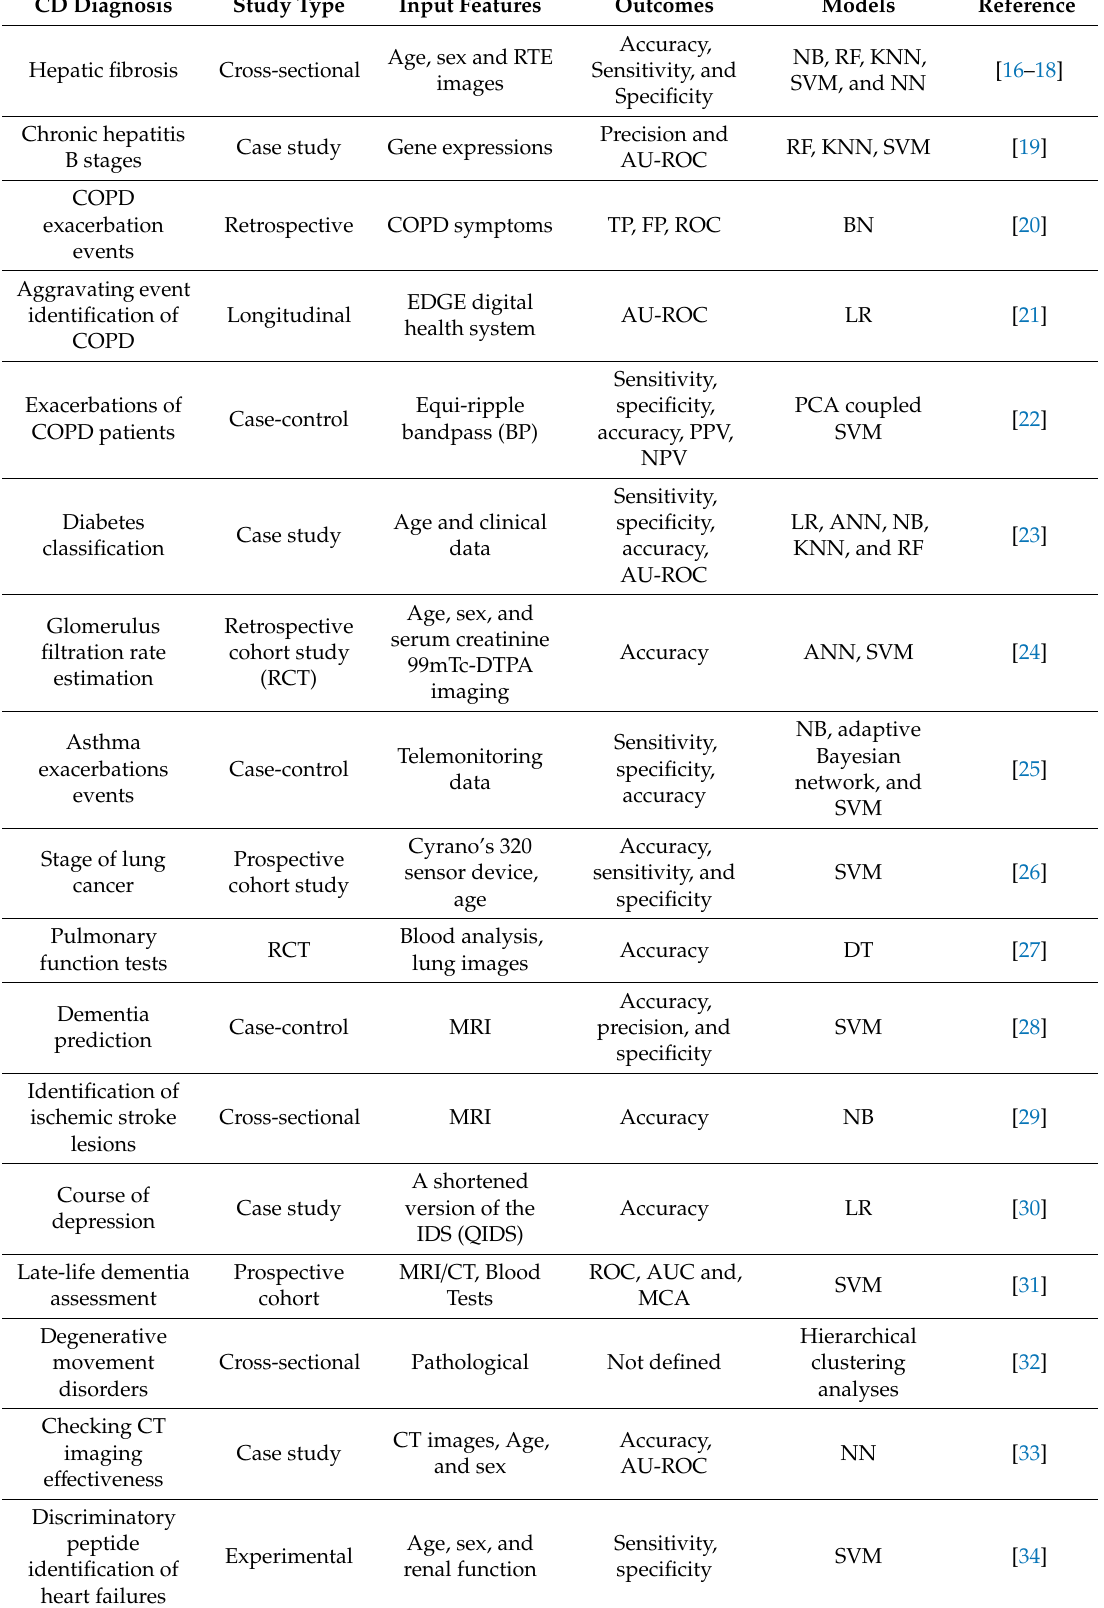
Table 1. Machine learning (ML) algorithms on di ff erent pathologies along with input features and outcomes